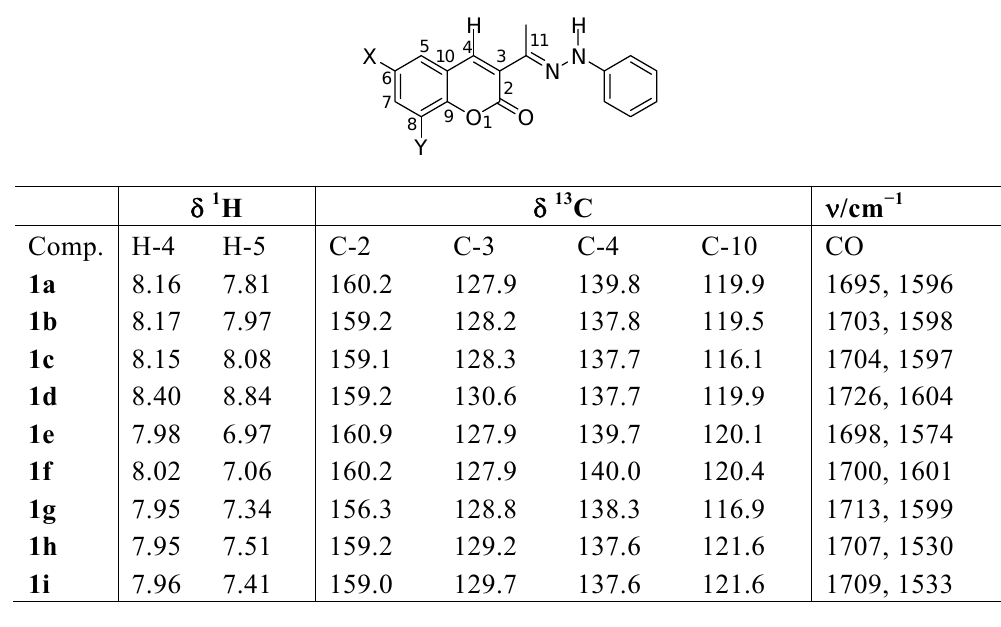
Table 1. Selected NMR and IR spectroscopic data for hydrazones 1a-i